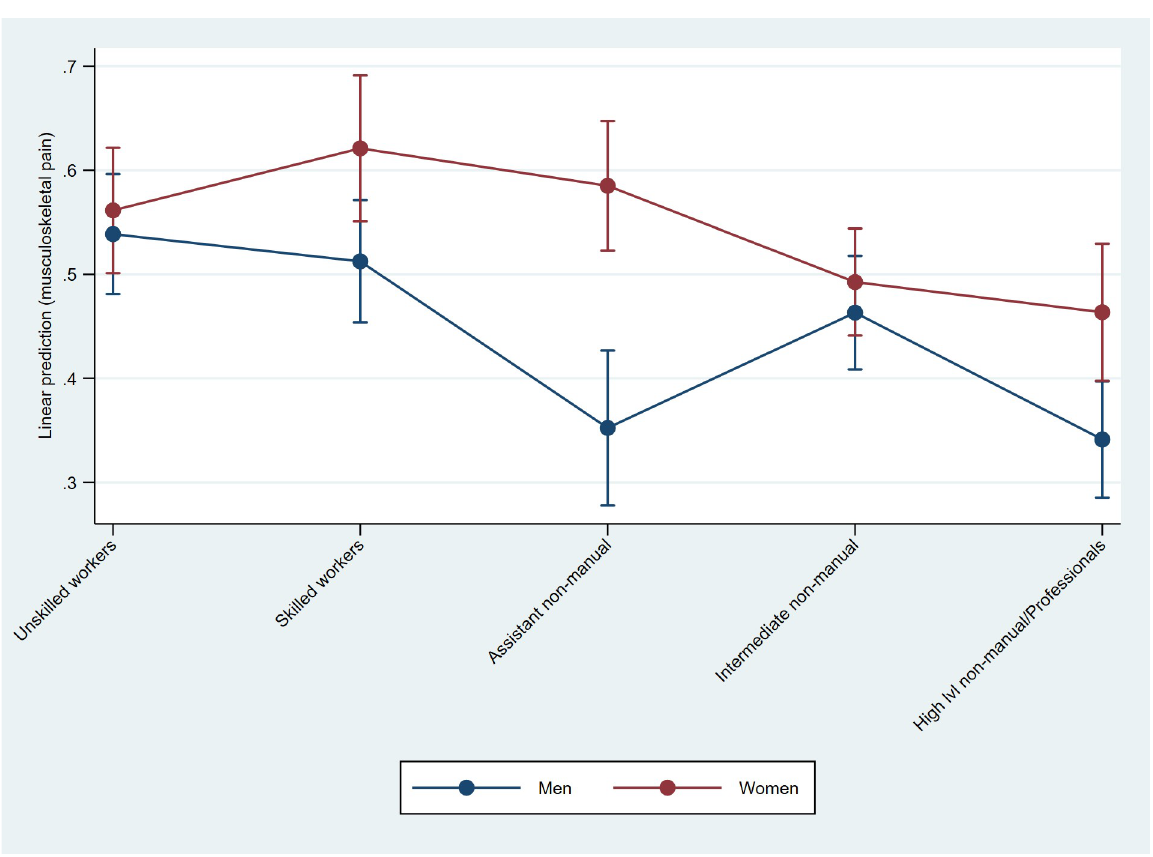
Fig 5. Predicted probabilities of musculoskeletal pain, by gender and class. Marginsplot based on linear probability model with mutual adjustment for gender and class (Table D in S3 Appendix).